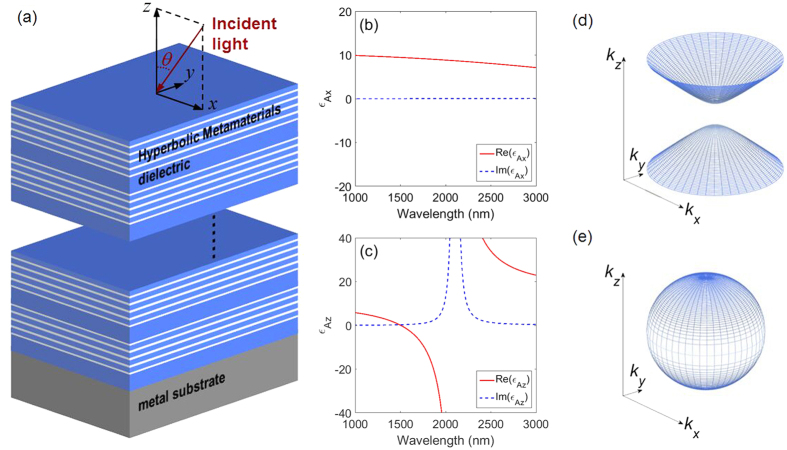
(a) The scheme of multilayer structure ((CD)S B)N on a metal substrate. Here HMM layer is mimicked by a subwavelength metallodielectric stack (CD)S. TM-polarized EM wave launches into the structure in x − z plane with angle of incidence θ. (b) The effective permittivity tensor εAx and (c) εAz of substructure (CD)S. Layer C is Si with dC = 39 nm and Layer D is ITO with dD = 11 nm. In the wavelength region of 1503~2103 nm substructure (CD)S can be mimicked as type-I HMMs. (d) Isofrequency surface in dispersion relation  for type-I HMMs with εx > 0 and εz < 0, which indicates . By contrast, isofrequency surface for conventional isotropic medium with εx = εz > 0 is exhibited in (e), which indicates .